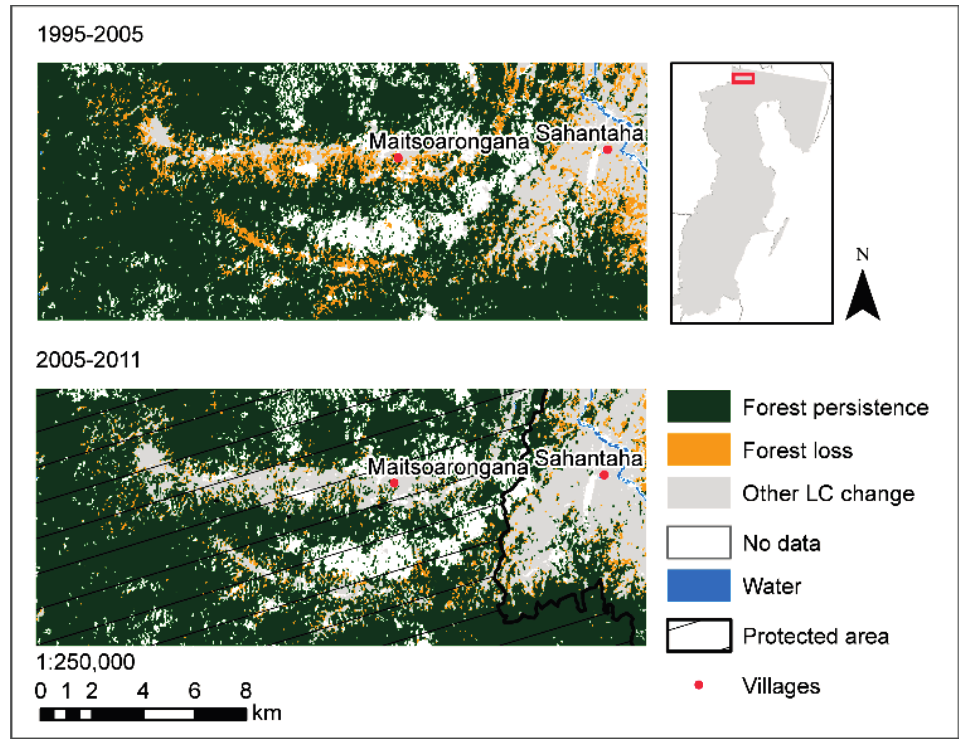
Figure 4. Example of forest loss before and after establishment of Makira Natural Park in